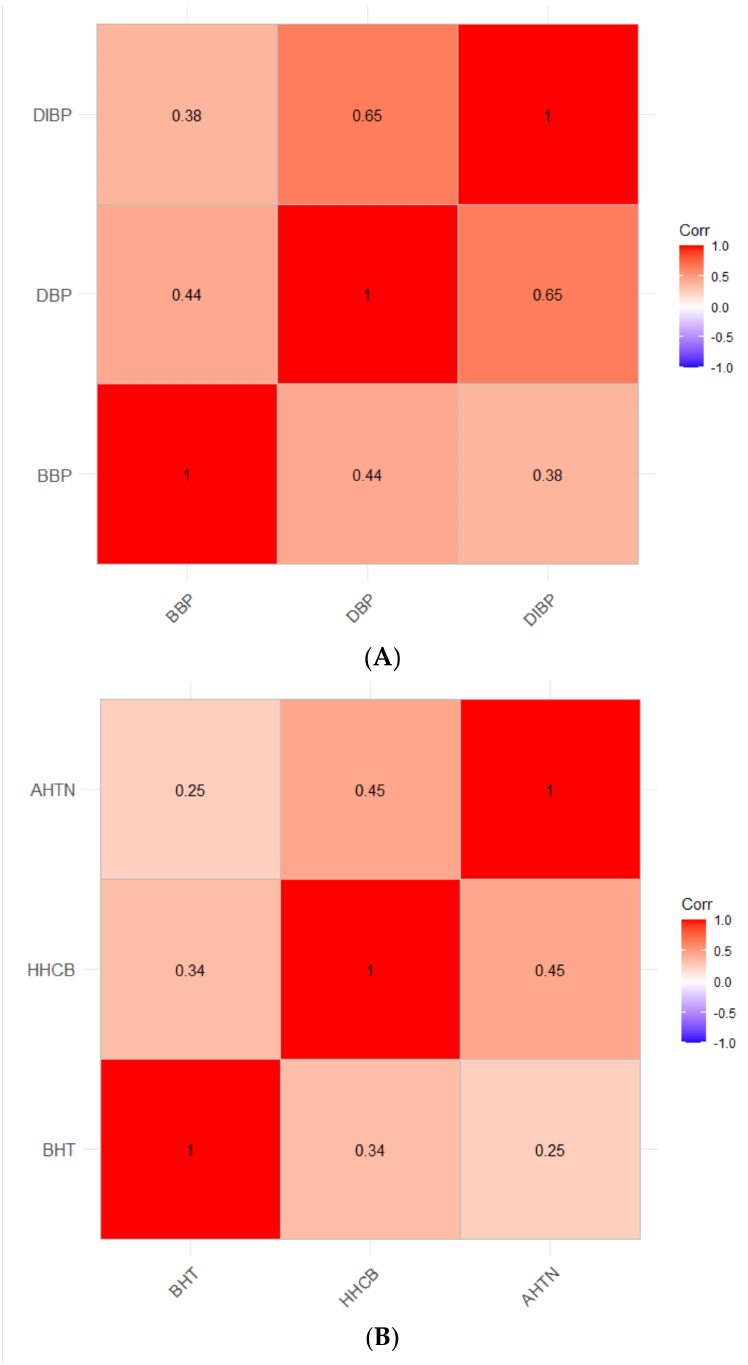
Figure 5. Correlation matrix investigating co-occurrence of real-world chemical concentrations for the most potent chemicals in ( A ) zebrafish and ( B ) NHBE, using exposure concentrations from Dixon et al., 2019, labeled with correlation coefficients. Only chemicals with significant correlations ( p < 0.01) are